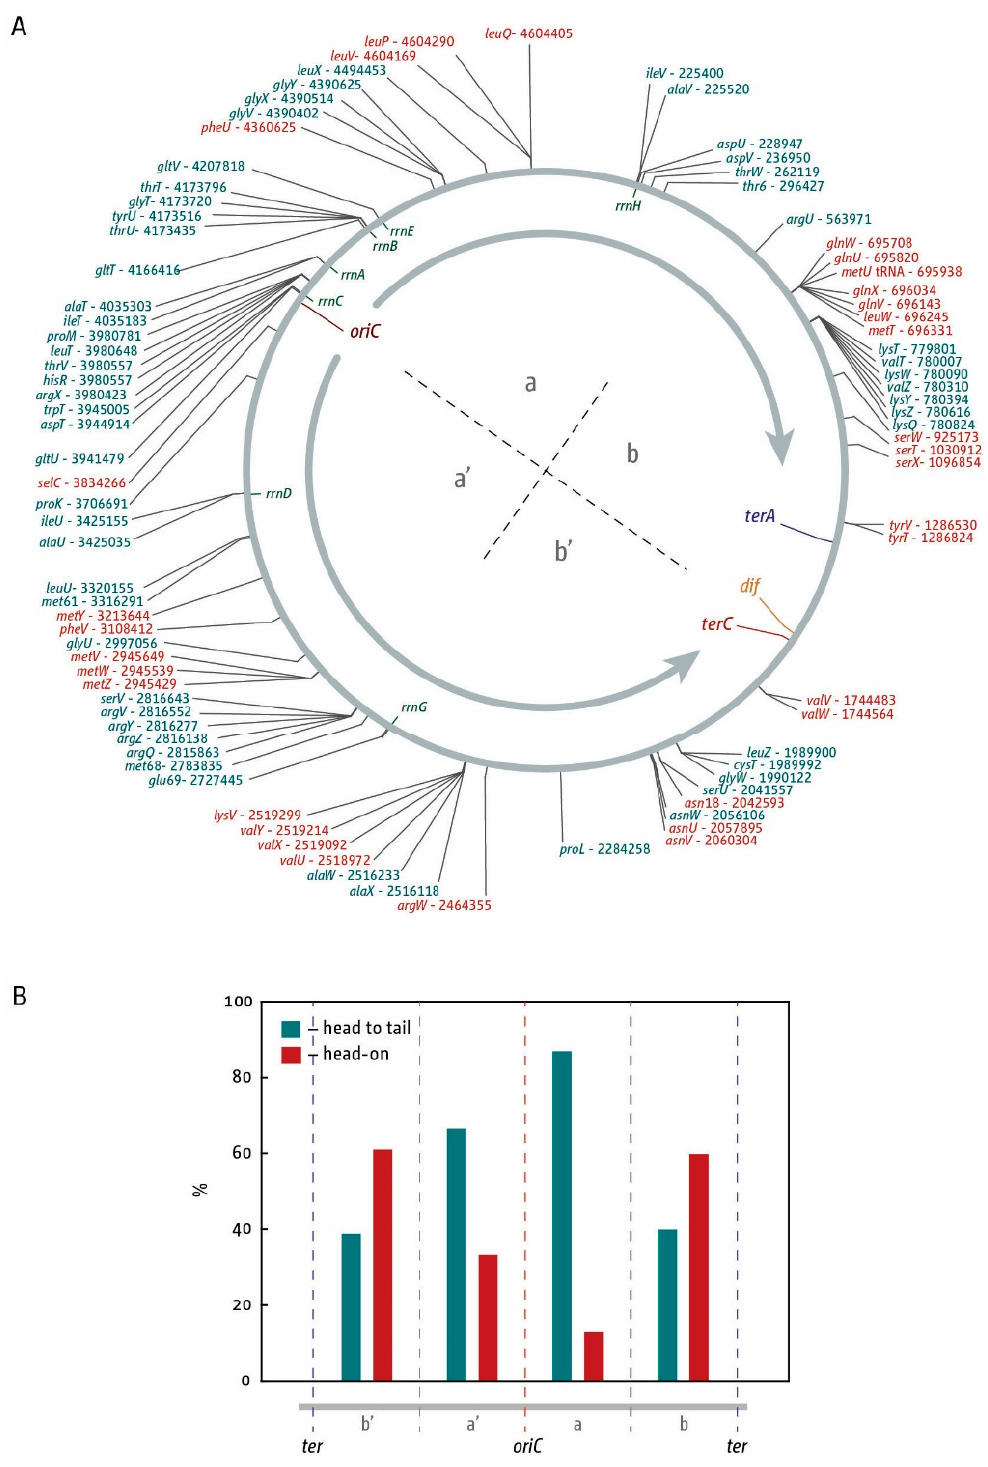
Figure 5. ( A ) Location and orientation of genes coding for tRNAs within the E. coli chromosome. oriC , the innermost ter sites, and the dif chromosome resolution dimer site as well as locations of rrn operons A–E , G , and H are indicated. Orientation of replication within a replichore is indicated by a grey arrow. Locations of tRNA genes are shown on the outside. Genes transcribed co ‐ directionally with replication are shown in cyan, genes transcribed in head ‐ on orientation relative to replication in the replichore are shown in red; ( B ) Frequency of head ‐ on (red) and head to tail (cyan) orientation relative to DNA replication of tRNA genes per chromosomal quarters. Quarters a and a’ are origin ‐ proximal, as shown in (A), while b and b’ are origin ‐ distal.